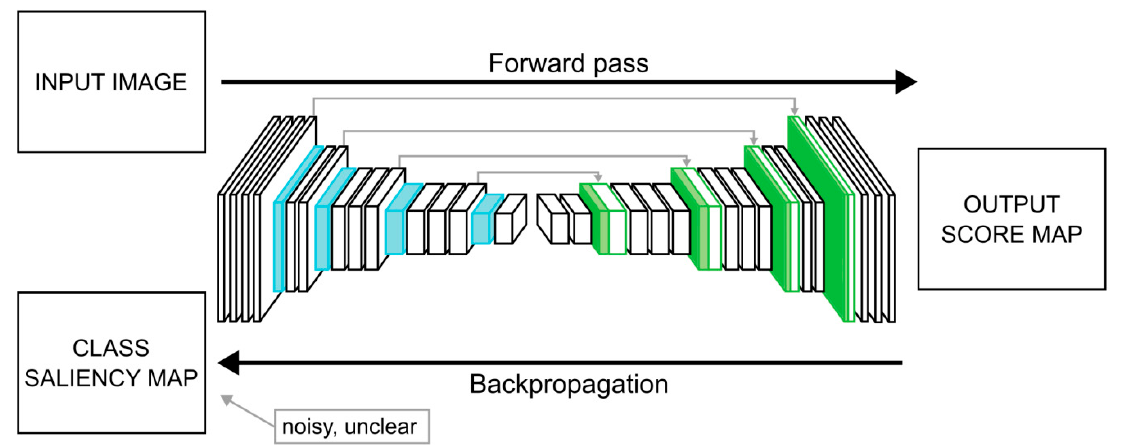
Figure 1. Class saliency map generation for semantic segmentation, computing the class saliency map of the output score map (class ‘car’) with respect to the input image. Brighter pixels indicate partial derivatives with higher absolute values.